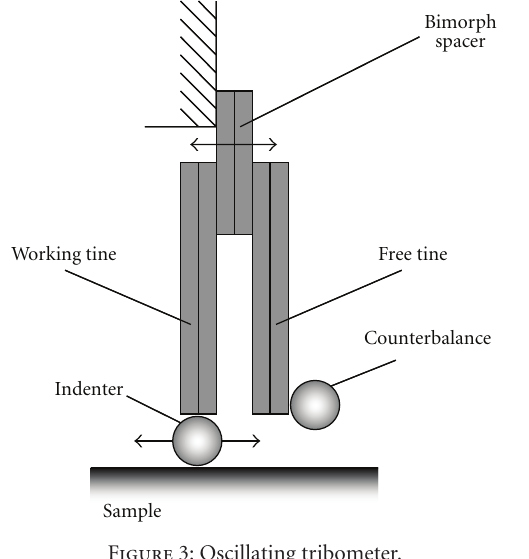
Figure 3: Oscillating tribometer.